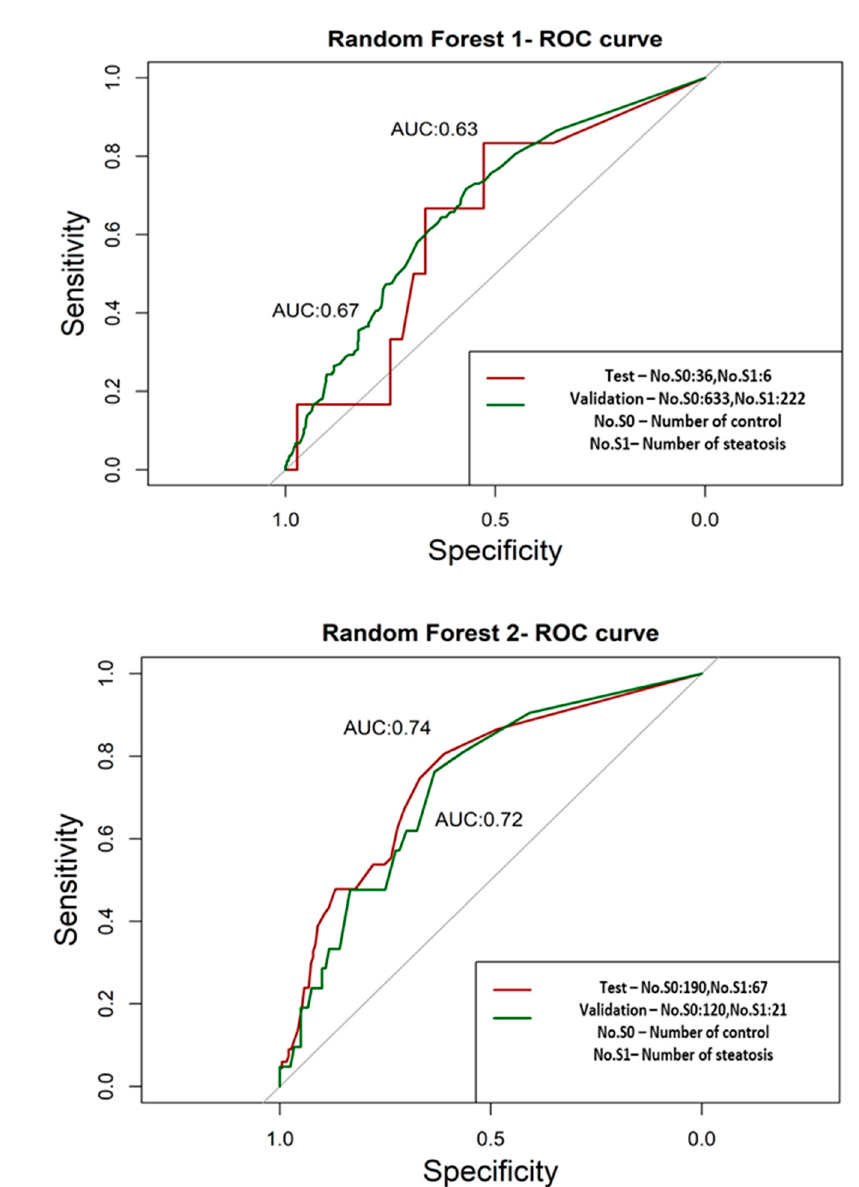
Figure 3. ( A ) Random forest 1 ROC curve that was formed using the Fenland cohort as the validation set. ( B ) Random forest 2 ROC curve that was formed using the Italian cohort as the validation set.